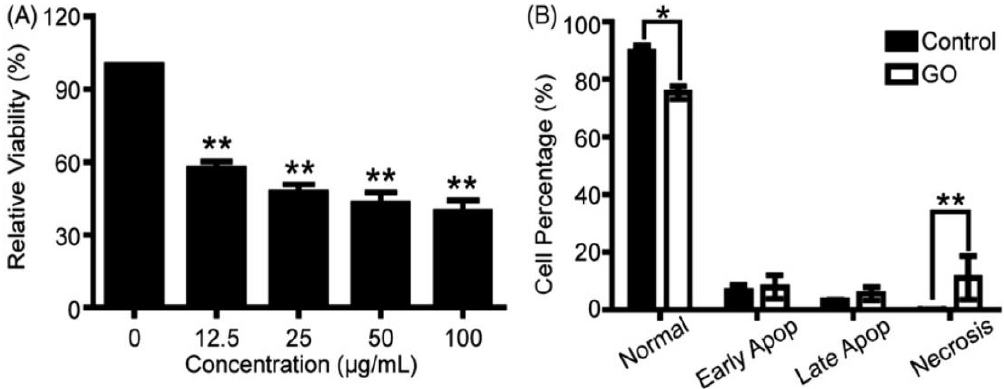
Figure 14. ( A ) WST-8 assay for hConECs exposed to GOs of different doses for 24 h. ( B ) Apoptosis flow cytometric analysis of hConECs exposed to GO (50 µg/mL) for 24 h. Three independent experiments were performed for both assays. Data were presented as mean ± SEM. * denotes p < 0.05 and ** represents p < 0.01. Reproduced from [113] with permission of Taylor & Francis.